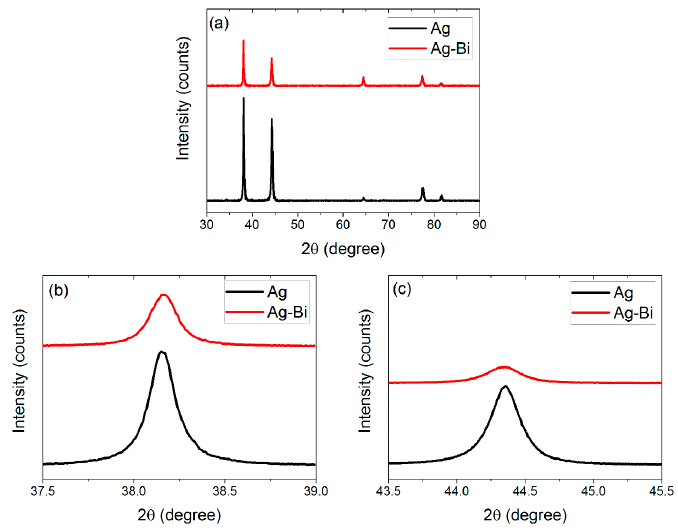
Figure 2. ( a ) XRD pattern of Ag and Ag-Bi coatings; ( b ) the magnified peak of Ag (111); and ( c ) the magnified peak of Ag (200).